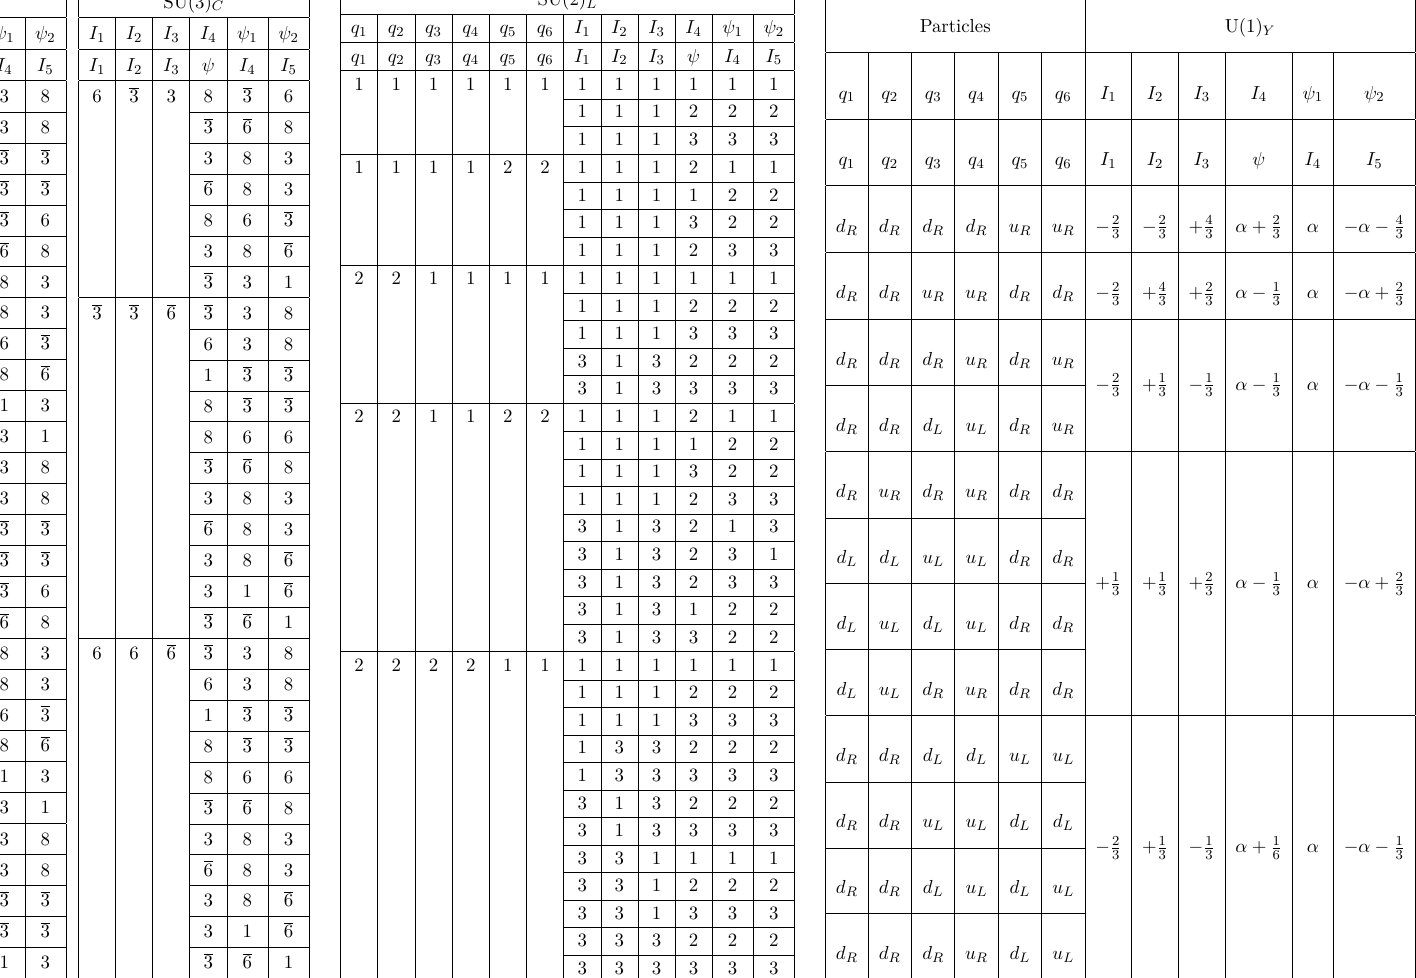
Table 17 . The possible quantum numbers of the fields in Topology-L-13 and